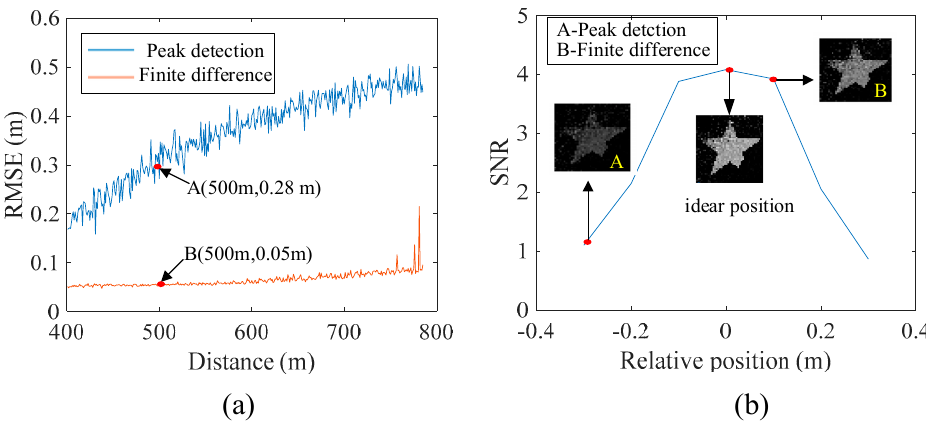
Figure 11. Comparative results based on finite difference and peak detection: ( a ) Root-mean-square errors (RMSEs) based on finite difference and peak detection, and ( b ) Relationship between relative position and signal-to-noise ratio